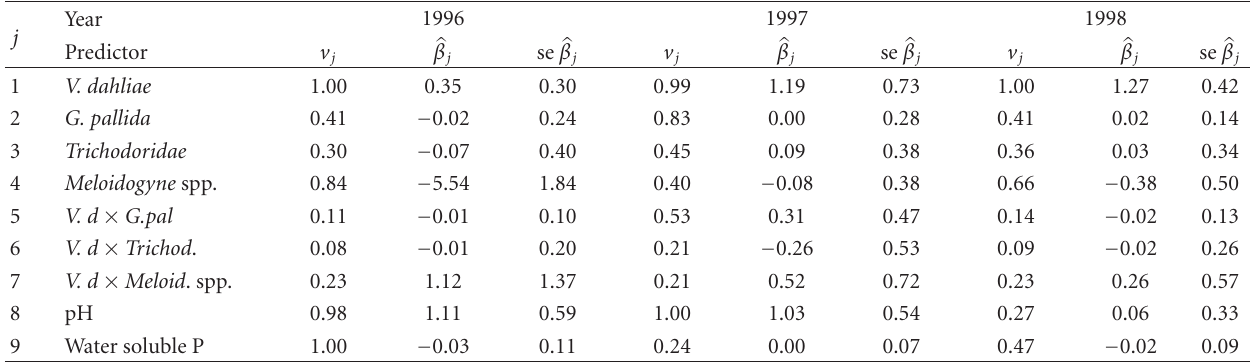
Table 4: Summed weights, v j = Σ wrI j ( r ), weighted regression coe ffi cients, (cid:10) β percentage haulms infected with V. dahliae in the years 1996, 1997, and